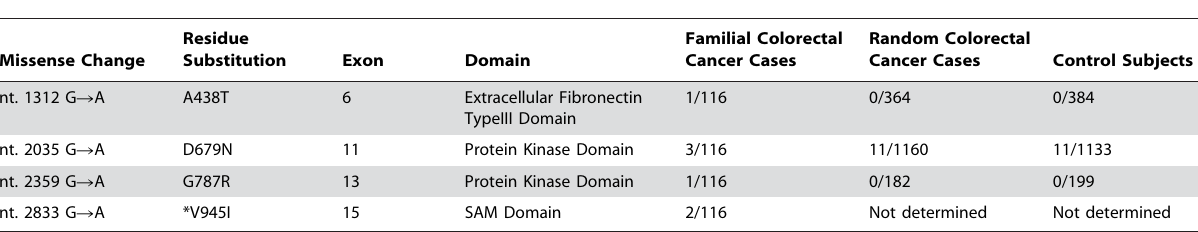
Table 1. Non-synonymous germline EPHB2 missense changes identified in familial and random colorectal cancer cases.